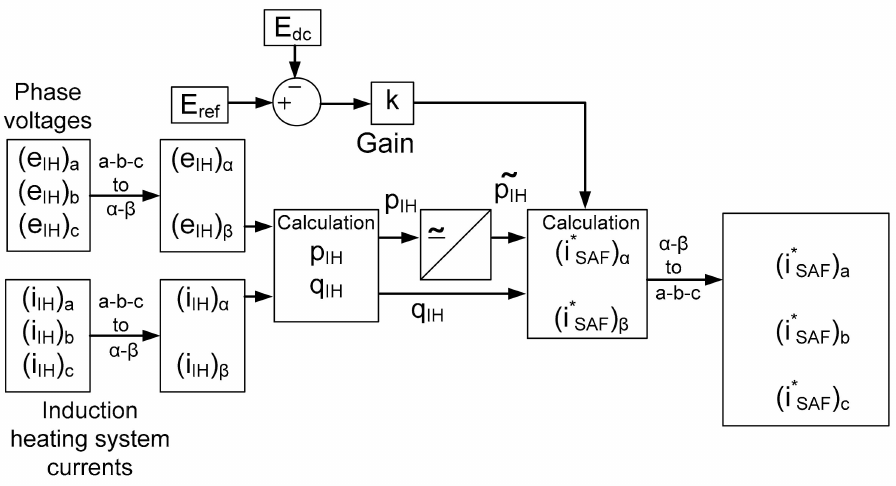
Figure 2. Proposed structure of the controller based on instantaneous power theory.